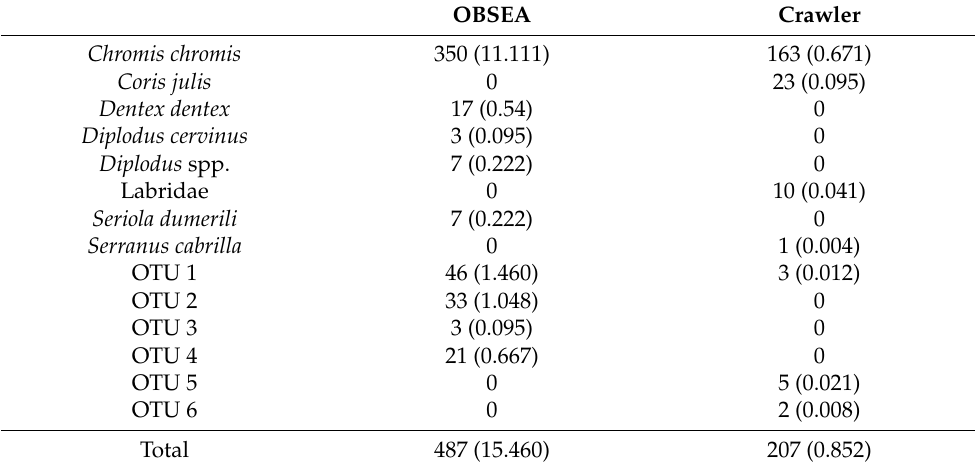
Table 2. The number of individuals for each taxon (and densities per m 3 in parentheses) as identified with the OBSEA and crawler cameras during the testing period. OTU refers to visible but not clas- sified individuals.